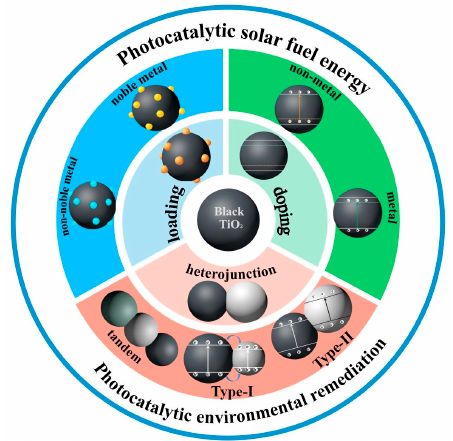
Figure 1. Outline diagram of the types of black TiO 2 nanomaterials.